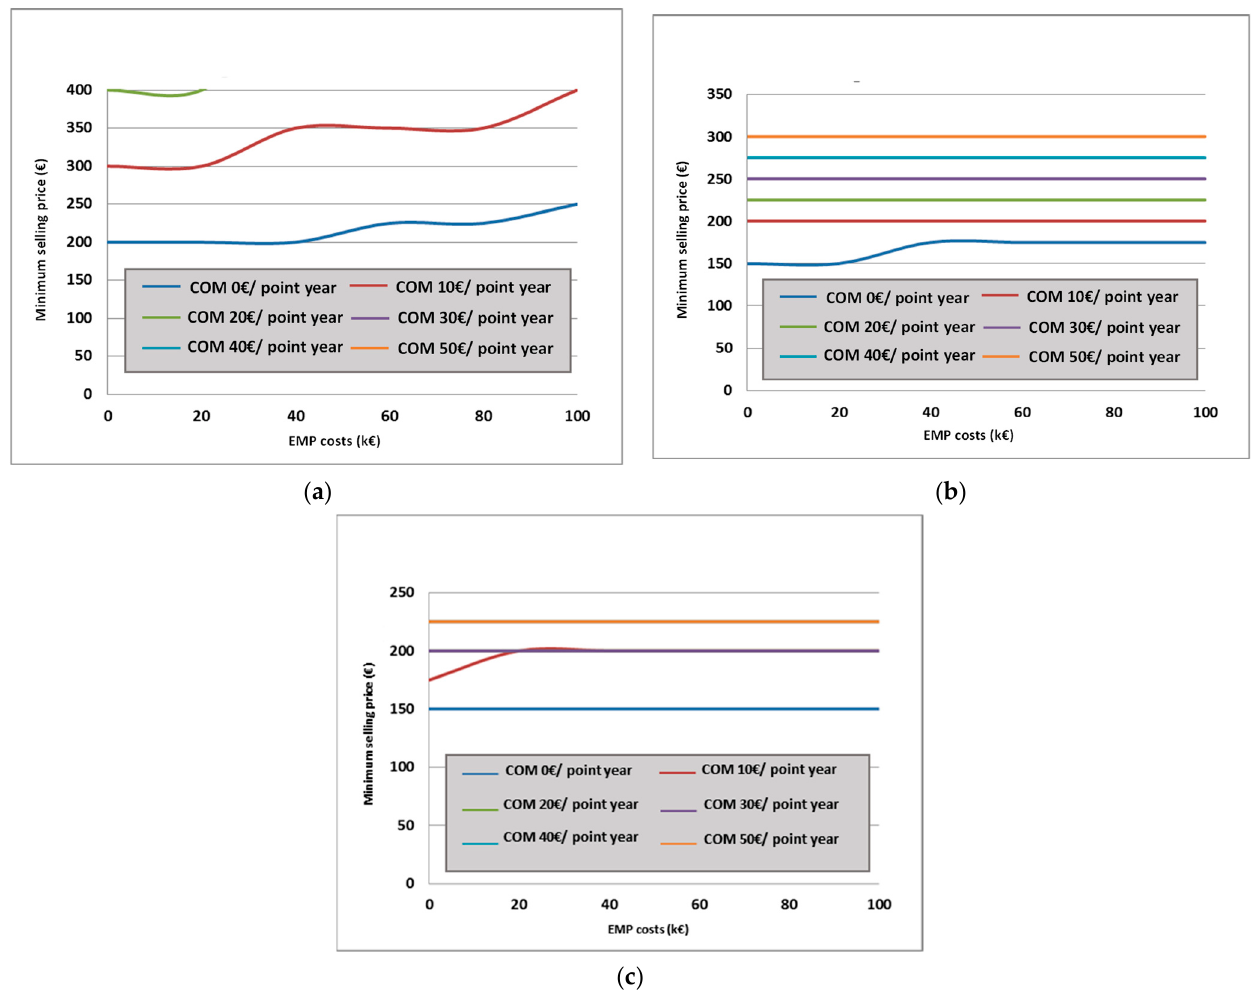
Figure 18. Sensitivity analysis on minimum price according to ASM market and the amount of en- ergy exchanged: ( a ) 500 MWh; ( b ) 2000 MWh; and ( c ) 4500 MWh . exchanged: ( a ) 500 MWh; ( b ) 2000 MWh; and ( c ) 4500